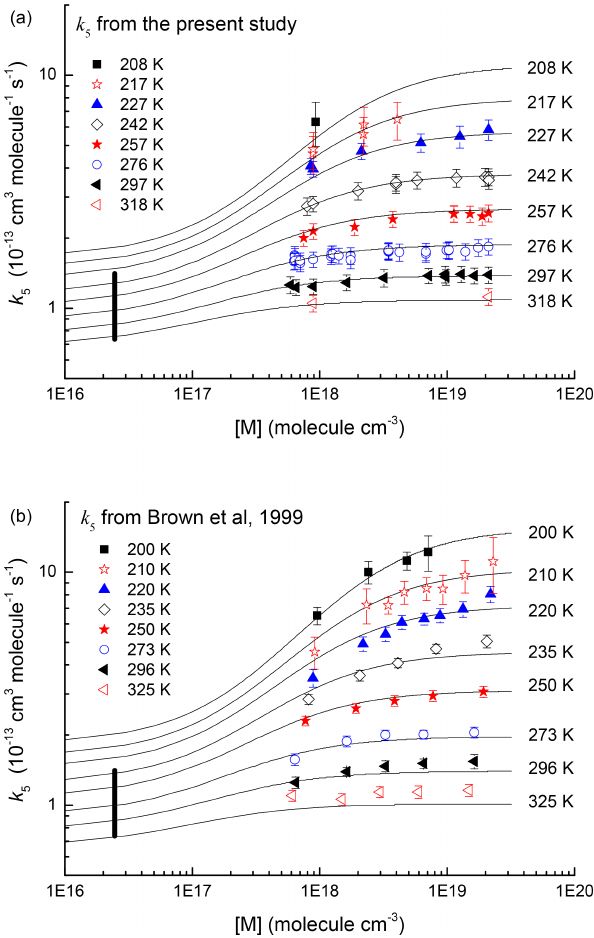
Figure 10. Rate coefficients k 5 as a function of pressure and tem- perature from Brown et al. (1999) (b) and the present study ( a , error bars represent total uncertainty). The solid lines were de- rived from the parameters listed in Table 1 (b) . The vertical line at M = 2 . 5 × 10 16 moleculecm − 3 (220–330K) represents the data set used to constrain the fit at low pressures and is given by the